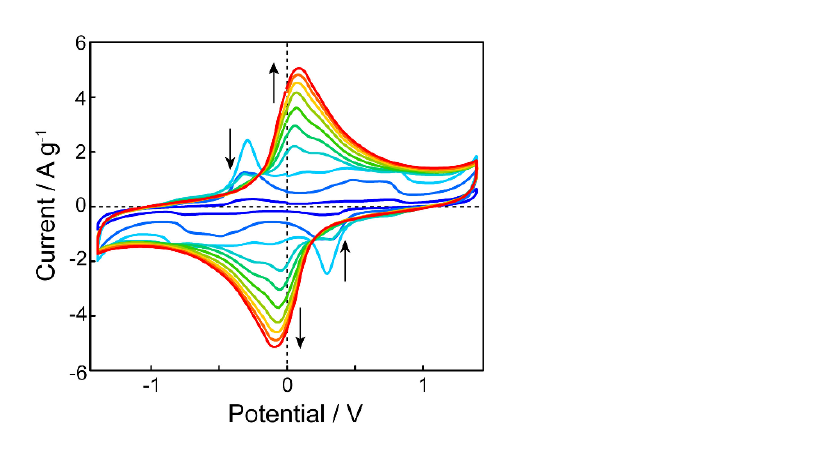
− 1 2 SO 4 ) at 100 mV s